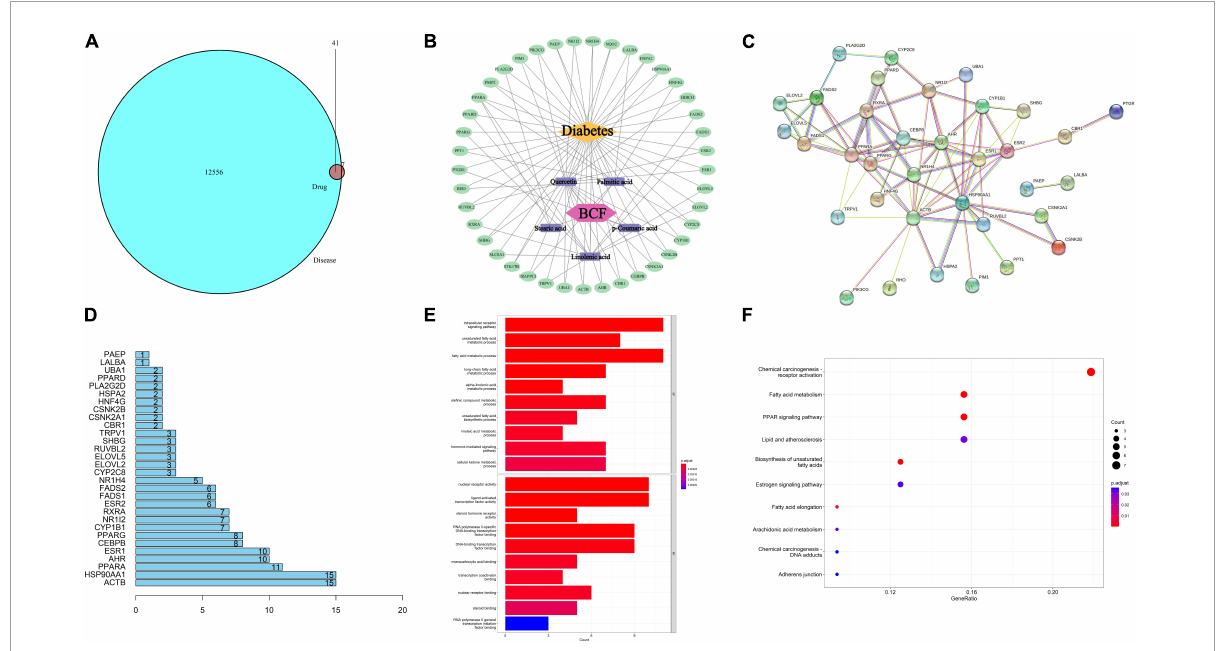
FIGURE8 Enriched KEGG pathways based on compounds identified by mass spectrometry in the EtOAc fraction of BCF. (A) The relationship between drug targets and disease targets; (B) BCF active ingredient-anti-diabetic target network; (C) PPI network of potential antidiabetic targets of BCF; (D) core gene histogram in PPI; (E) column chart of GO functional enrichment results of BCF potential anti-diabetic targets; (F) KEGG signaling pathway enrichment analysis bubble